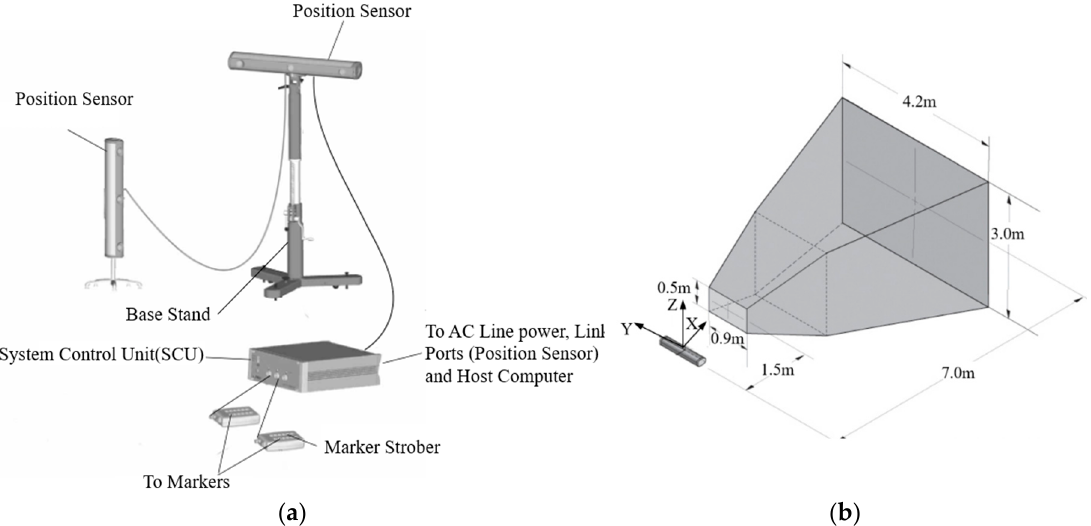
Figure 4. Gait capture system ( a ) and its coordinate system and measurement space ( b ).